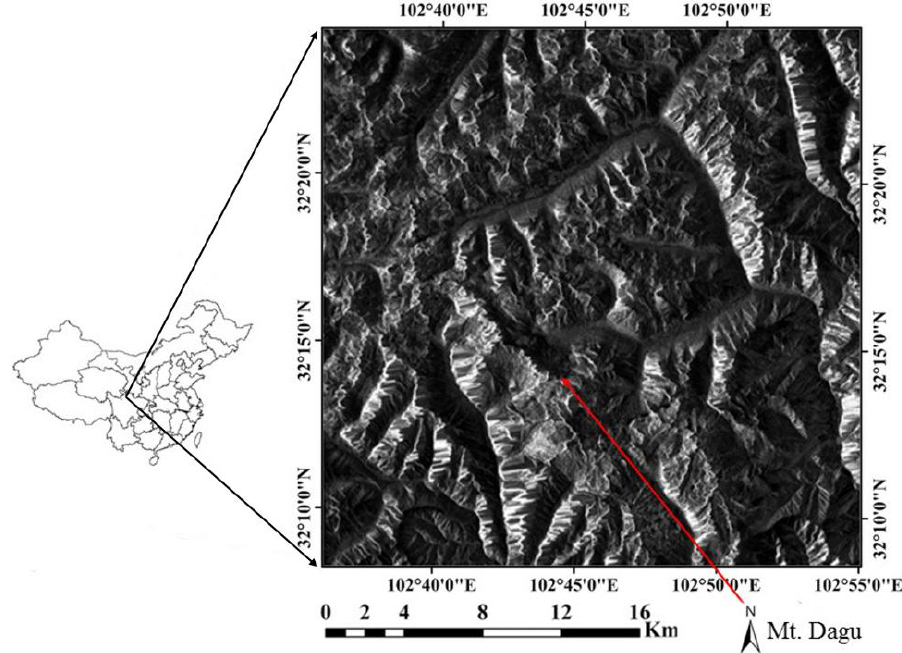
Figure 1. PALSAR L-HH image in ground range showing Mt. Dagu, Sichuan, China. The image is in gray scale, and covers an area of 27 km × 27